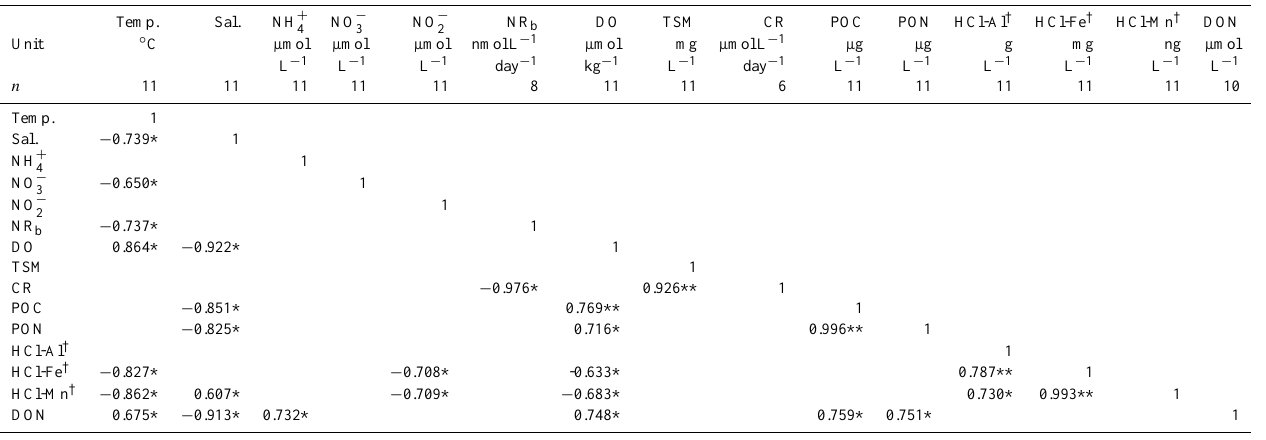
Table 2c. Correlation matrix of field-surveyed data in the outer plume of the Chang Jiang River plume. Temp.